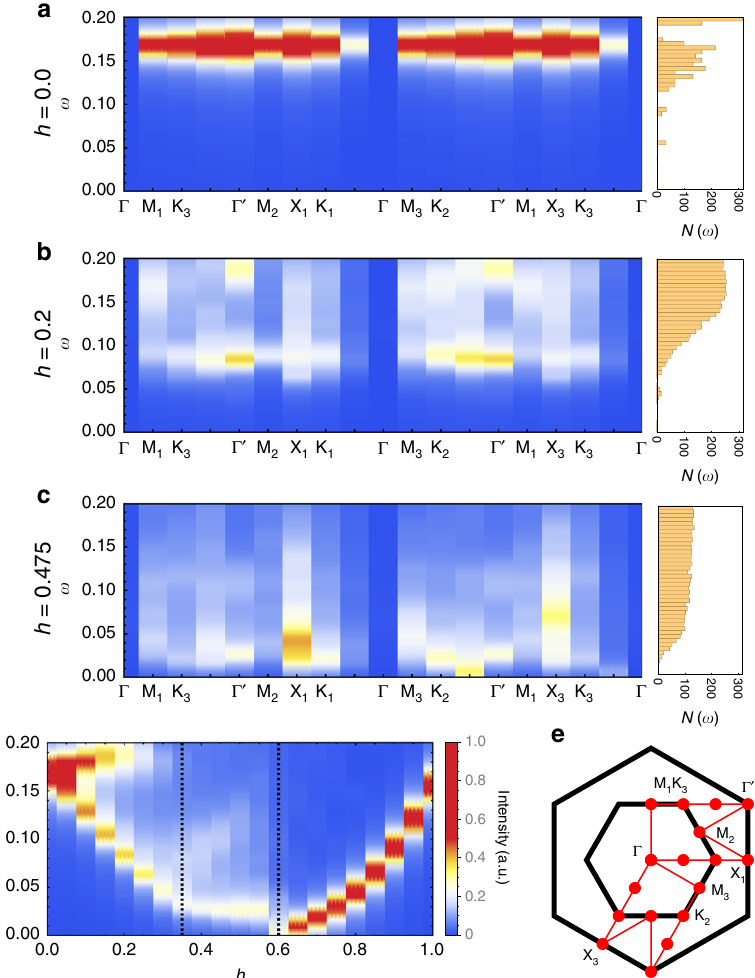
Fig. 4 Dynamical spin structure factor. a The zero- fi eld KSL, b a point midway in the KSL phase, and c a point in the middle of the GSL along a path through all high-symmetry points of the extended Brillouin zone as illustrated in ( e ). In d , the intensity at the Γ ′ point is shown as a function of increasing fi eld along the cut θ = 82.5°, the upper of the two dashed red lines in Fig.